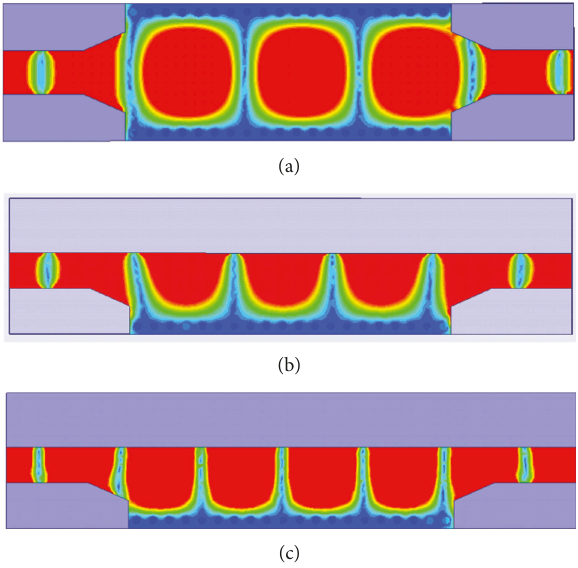
Figure 3: Simulated surface E- fi led distribution of substrate- integrated waveguides at 20 GHz. (a) Substrate-integrated waveguide; (b) half-mode substrate-integrated waveguide; (c) slow-wave half-mode substrate-integrated waveguide.